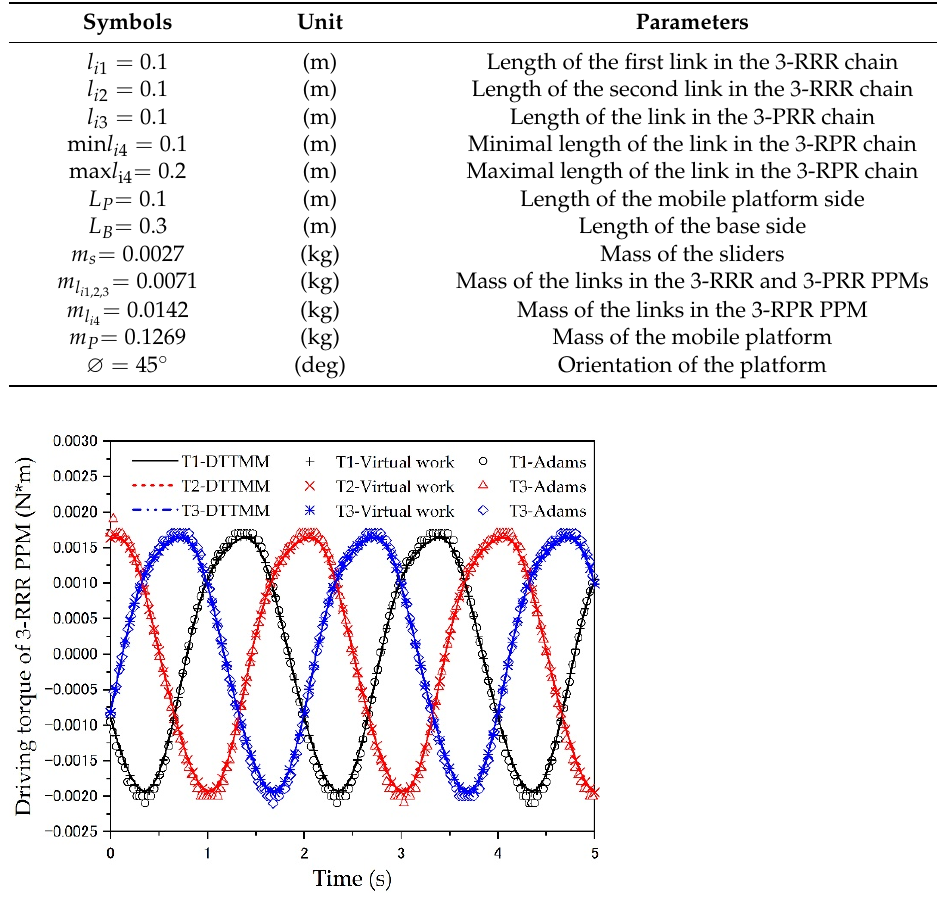
Table 1. Parameters of the three PPMs.